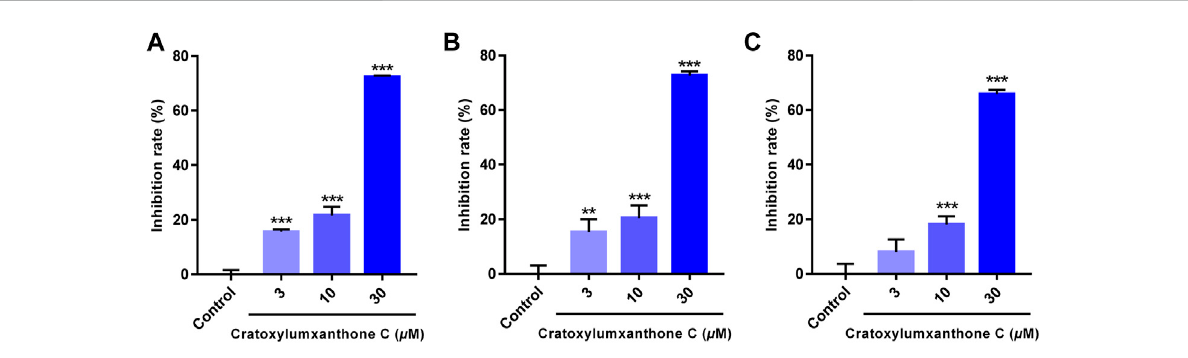
FIGURE 2 Cratoxylumxanthone C inhibited the proliferation and viability of three human cancer cell lines. A549 (A) , HepG2 (B) and MCF7 (C) cells were treated with cratoxylumxanthone C (3, 10, and 30 μ M) for 48 h. Cell viability was detected by MTT assay. The results are presented as means ± SD. **p < 0.01 and ***p < 0.001 versus control group.